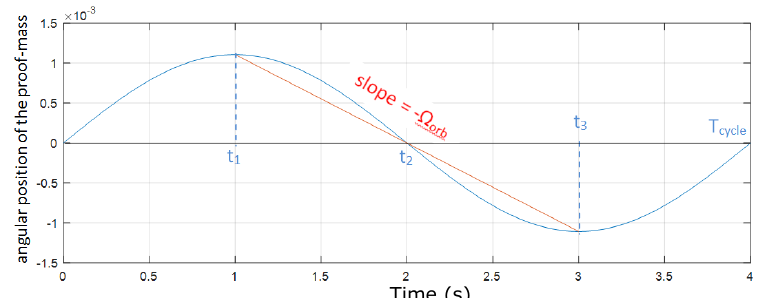
Figure 24. Control of the electrostatic proof-mass angular position during an interferometric cycle. The angular velocity to be compensated between t 1 (first CAI laser pulse) and t 3 (last CAI laser pulse) is represented in